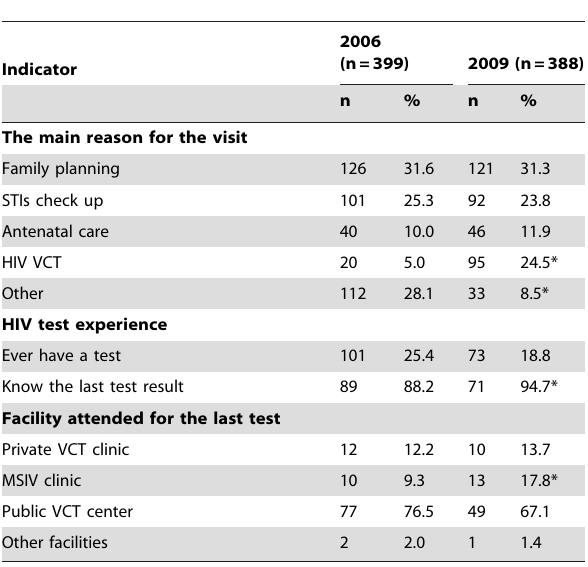
Table 4. Demographic characteristics of exit clients. Table 5. HIV testing attitudes and experience of exit